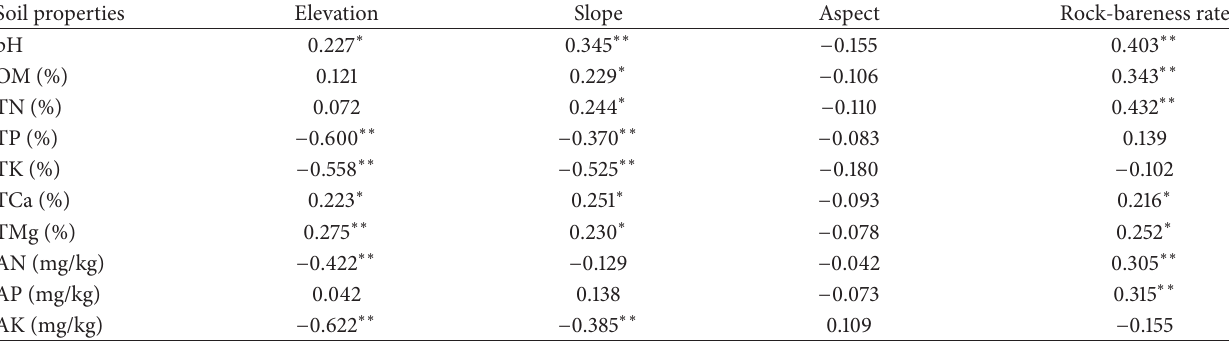
Table 3: Correlation between the soil chemical properties and topographic factors (elevation, slope, aspect, and rock-bareness rate). Soil